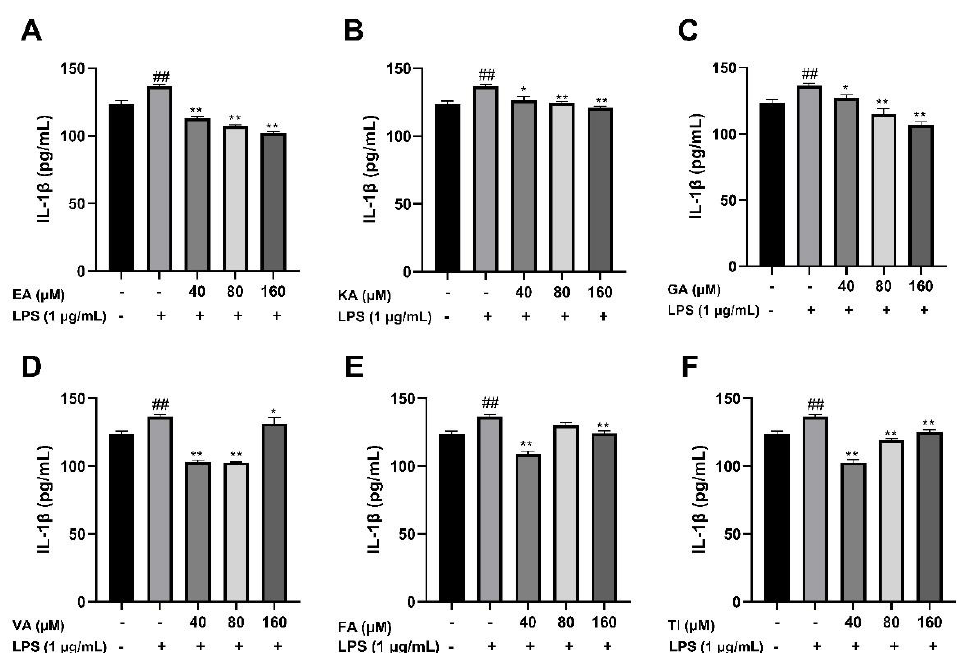
Figure 19. Effects of Ellagic acid ( A : EA), Kaempferol-3-o-rutin glycoside ( B : KA), Gallic acid ( C : GA), Vanillic acid ( D : VA), Ferulic acid ( E : FA), and Tiliroside ( F : TI) on LPS -induced IL-1 β in BV2 cells at high (160 µ M), medium (80 µ M) and low (40 µ M) concentrations. − indicates that contain, + indicates does not contain. ## represent significant difference between the representative model group and the control group. * represents significant difference compared with model group ( p < 0.05); ** represents extremely significant difference compared with model group ( p <